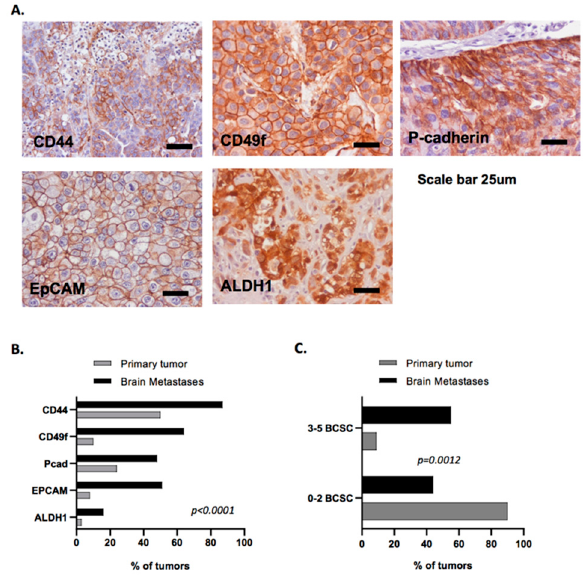
Figure 3. Human breast cancer brain metastases are enriched in breast cancer stem cell markers. ( A ) Illustrative representation of the immunohistochemical evaluation of the breast cancer stem cell markers CD44, CD49f, P-cadherin, EpCAM, and ALDH1 in human brain metastases. Scale = 25 µ m. ( B ) Percentage of positive tumors with expression for each BCSC marker (CD44, CD49f, P-cadherin, EpCAM, and ALDH1) in the breast cancer brain metastases series vs. primary breast cancer patients. ( C ) Percentage of positive tumors with BR-BCSC signature (expression of any combination of 3–5 BCSC) in the breast cancer brain metastases series vs. primary breast cancer patients. Associations between the expression of the markers evaluated in primary tumors and breast cancer brain metastases were assessed by Pearson’s χ